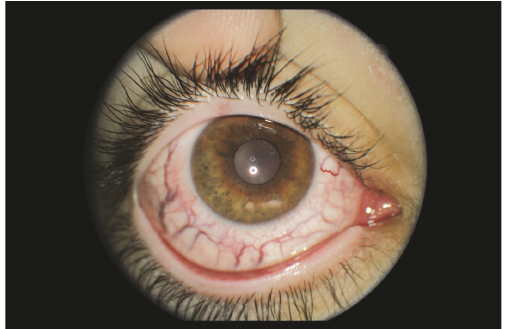
Figure 1: Right eye showing abnormally dilated episcleral vasculature.